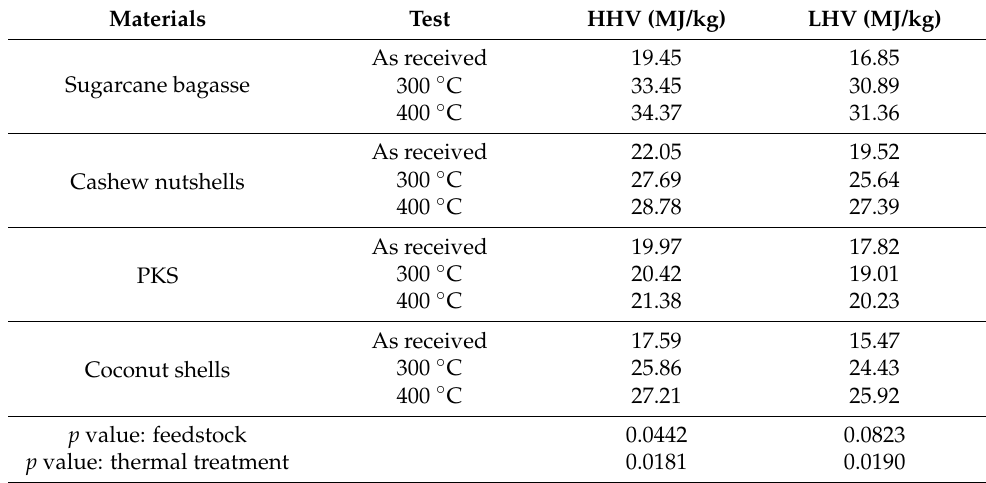
Table 4. Values calculated for high heating value (HHV) and low heating value